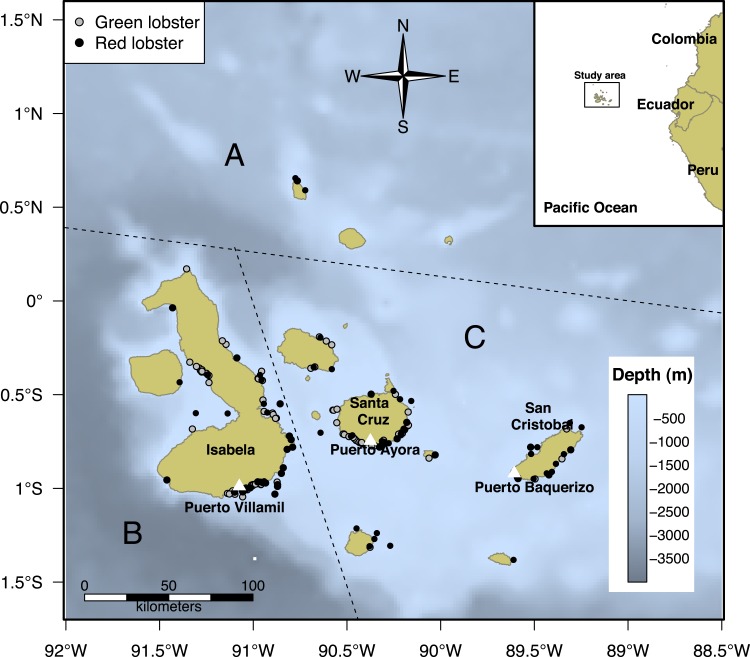
Biogeographic division of the Galapagos Islands by region: North (A), West (B), and Centre-South (C); modified from Edgar et al. (2004).The black dots represent fishing trips in the grounds where Panulirus penicillatus (red lobster) was captured by fishers in the area and the gray dots correspond to trips directed to Panulirus gracilis (green lobster). Information about distribution of both species represented by black and gray dots was recorded by the onboard observers during the monitoring program in the study period (2002–2008).